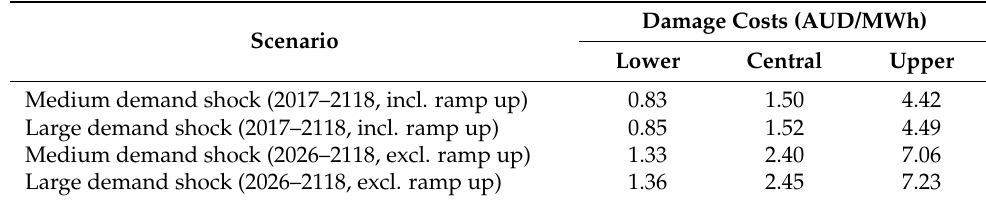
Table 4. Health benefit of CEP measures in the NSW Greater Metropolitan Region emissions. AUD2016/MWh using 7% discount